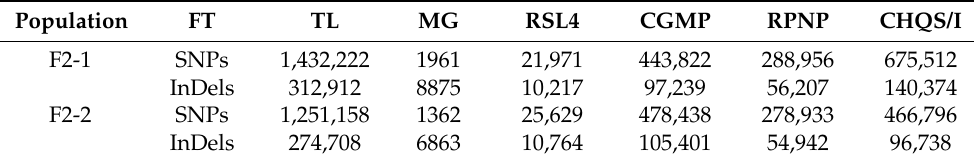
Table 3. Credible and high-quality SNPs/InDels in